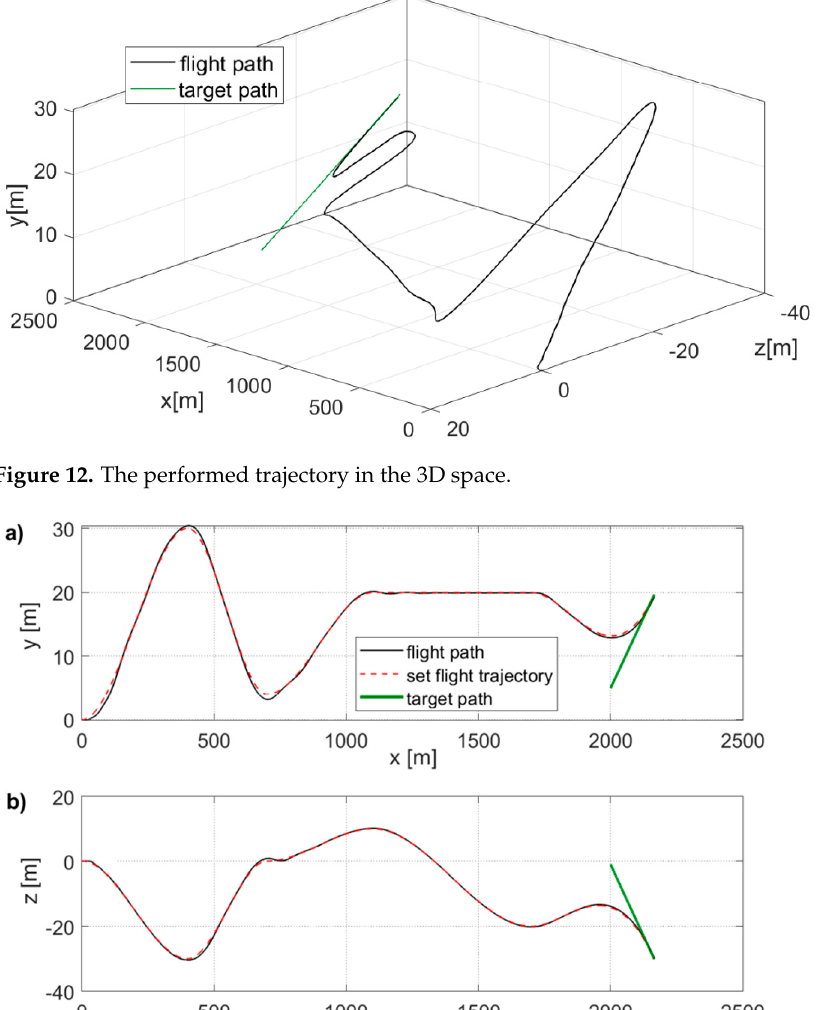
Figure 13. The performed and desired flight trajectory in ( a ) the vertical plane; ( b ) the horizontal plane.